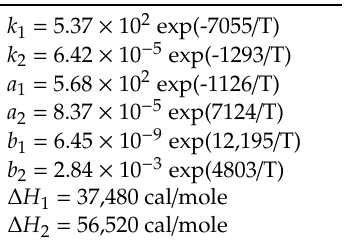
Table 2. Kinetic parameters for the